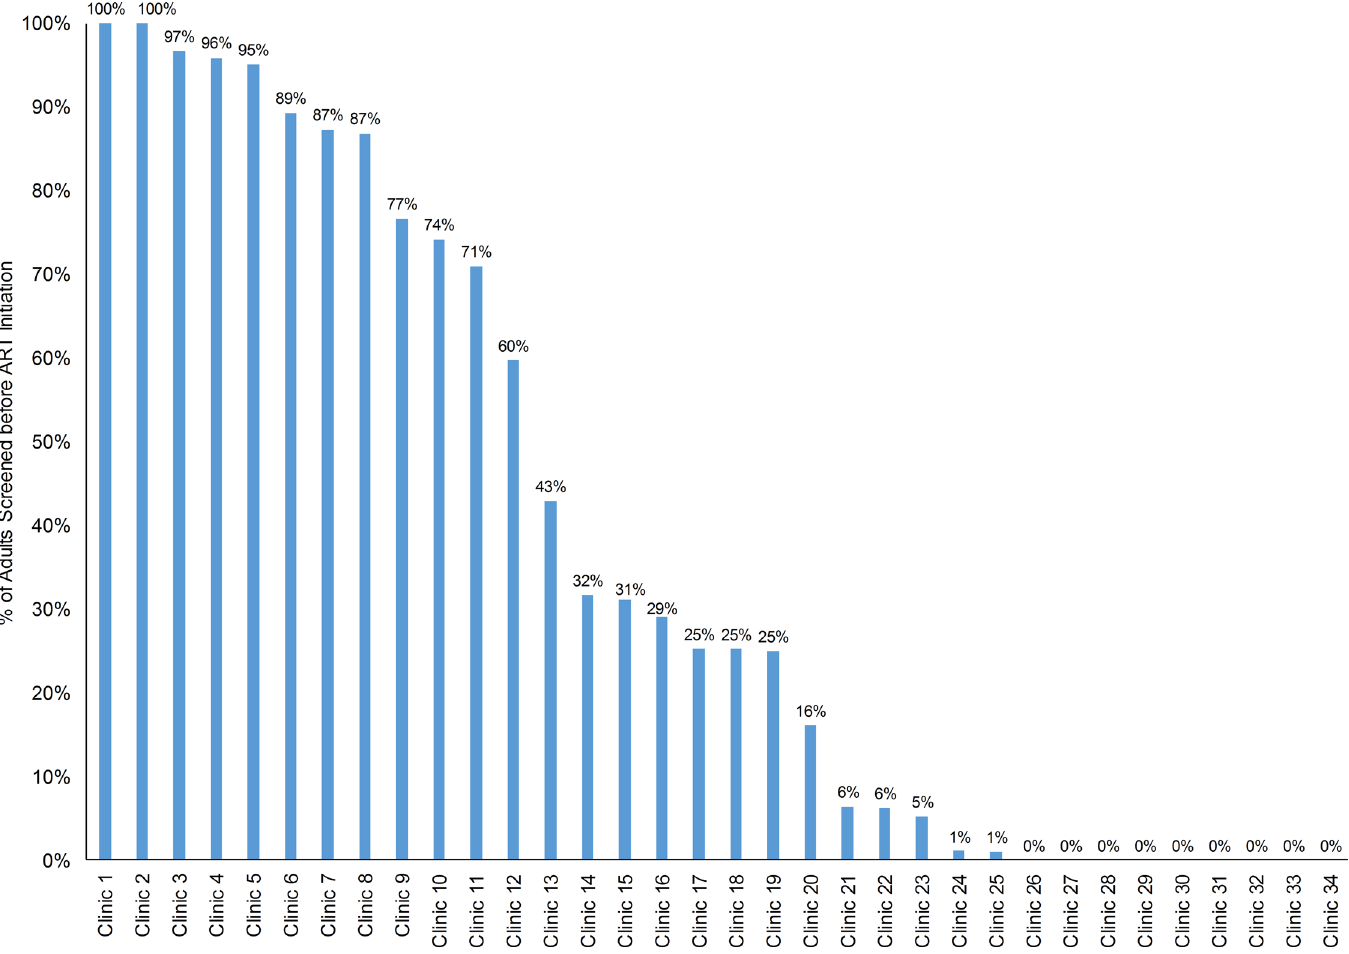
Fig 2. Facility-Level Variations in the Percentage of Adults Screened for Tuberculosis before Antiretroviral Therapy Initiation in Côte d ’ Ivoire during 2004 – 2007.